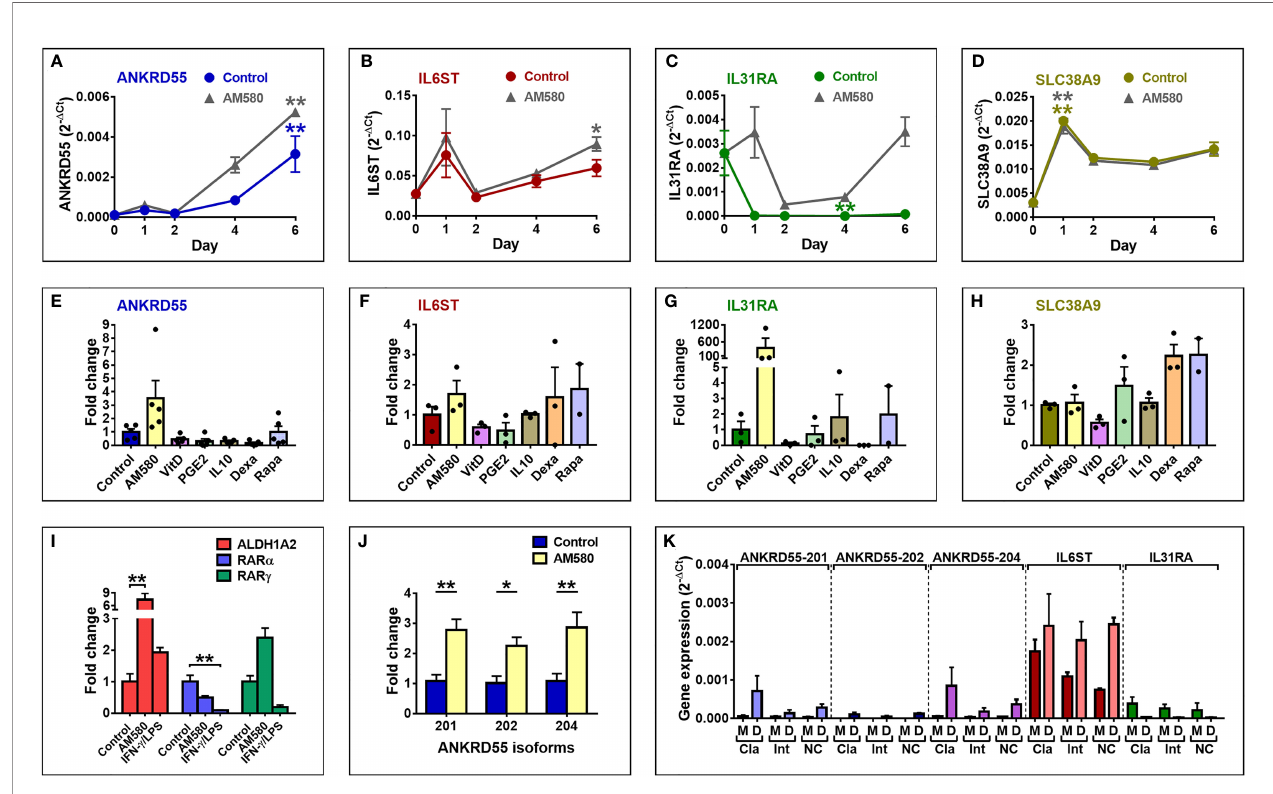
FIGURE 2 | Expression of ANKRD55 and neighboring genes in immature moDC. (A – D) Monocytes were cultivated for 6 days in IL-4/GM-CSF medium for differentiation into immature moDC in the absence (colored curves) or presence (gray curves) of AM-580, and expression levels of the indicated genes were measured by qPCR at the start of the cultivation (day 0) and on days 1, 2, 4, and 6. Mean ± SEM of 3 independent measurements; Friedman test (followed by Dunn ’ s multiple comparison test) for comparison of data points in each curve with day 0 and Wilcoxon test for comparison of both curves (Control vs. AM580). (E – H) Effect of tolerogenic compounds on gene expression in immature moDC by qPCR. Concentrations of compounds are provided in the Materials and Methods . Mean ± SEM of maximum 5 independent measurements; Friedman test (followed by Dunn ’ s multiple comparison test). (I) Analysis of ALDH1A2, RAR a , and RAR g expression by qPCR. Mean ± SEM; n = 6; Friedman test (followed by Dunn ’ s multiple comparison test). (J) Expression levels of three discrete ANKRD55 splice variants 201, 202, and 204 in immature moDC. Mean ± SEM; n = 10; Wilcoxon test. (K) Classical (Cla; CD14 hi /CD16 - ), intermediate (Int; CD14 hi /CD16 + ), and non- classical (NC; CD14 + /CD16 + ) monocytes were isolated and separately cultivated for 6 days to differentiate into moDC. Gene expression levels were measured in the original monocyte subsets (M) and derived moDC (D). Mean ± SEM; n = 3; Mann – Whitney test for comparison between monocytes and moDC for each gene and subset. * p ≤ 0.05, ** p ≤